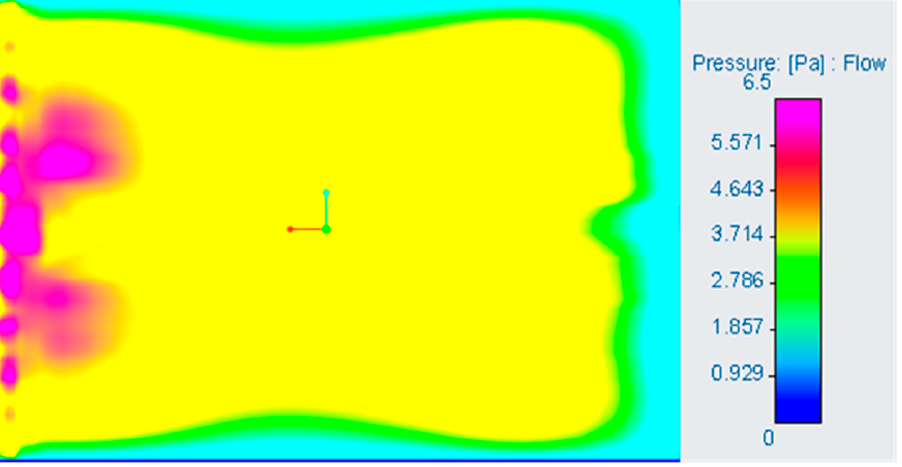
Figure 13. Cloud map of the final pressure distribution.